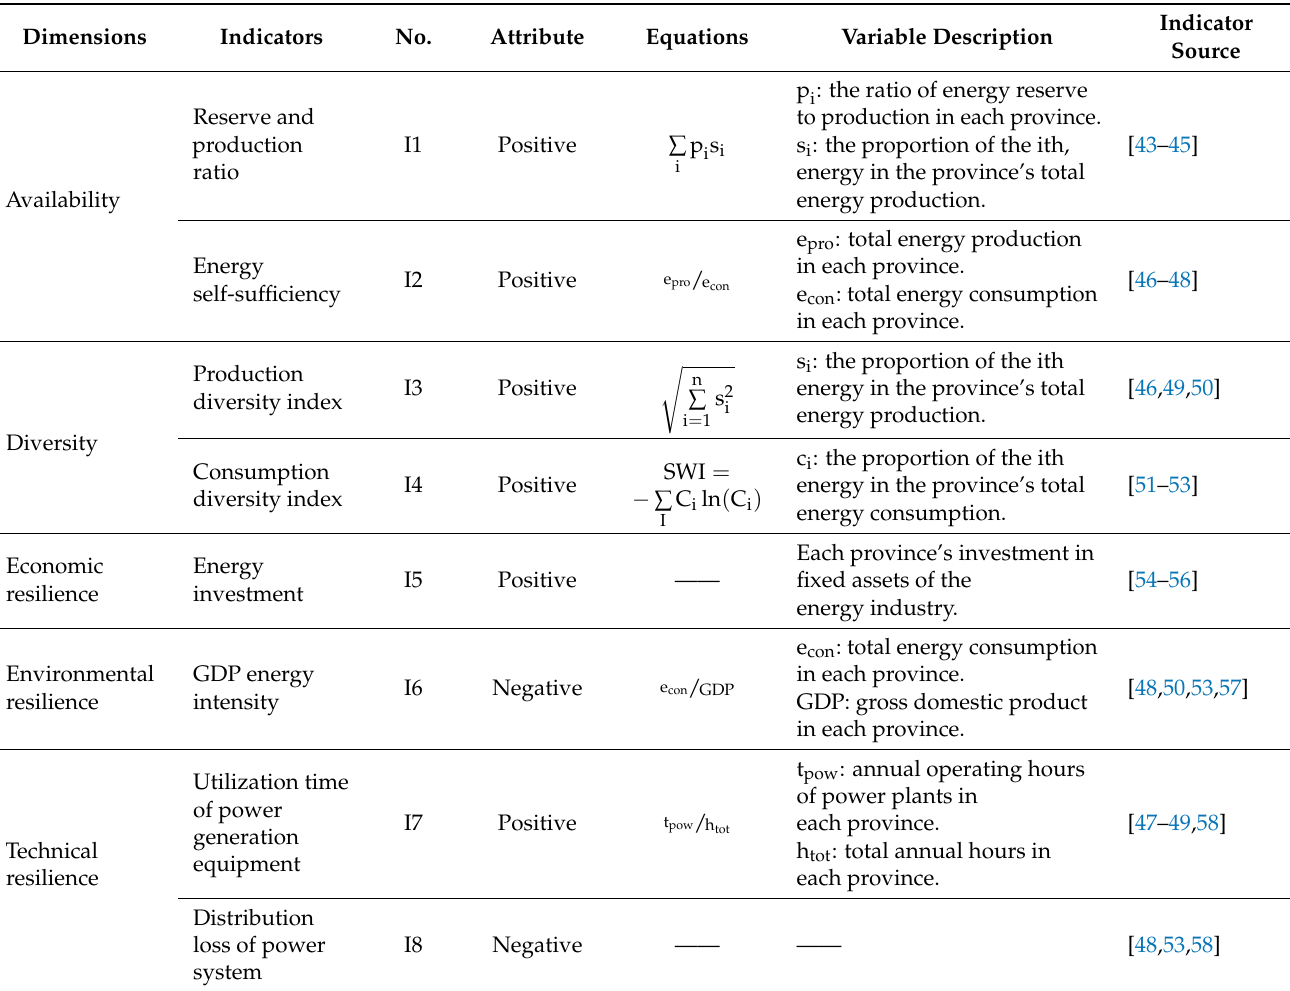
Figure 2. Relation between energy indicators and energy resilience. Table 1. The calculation process of each indicator and sources for CERI.